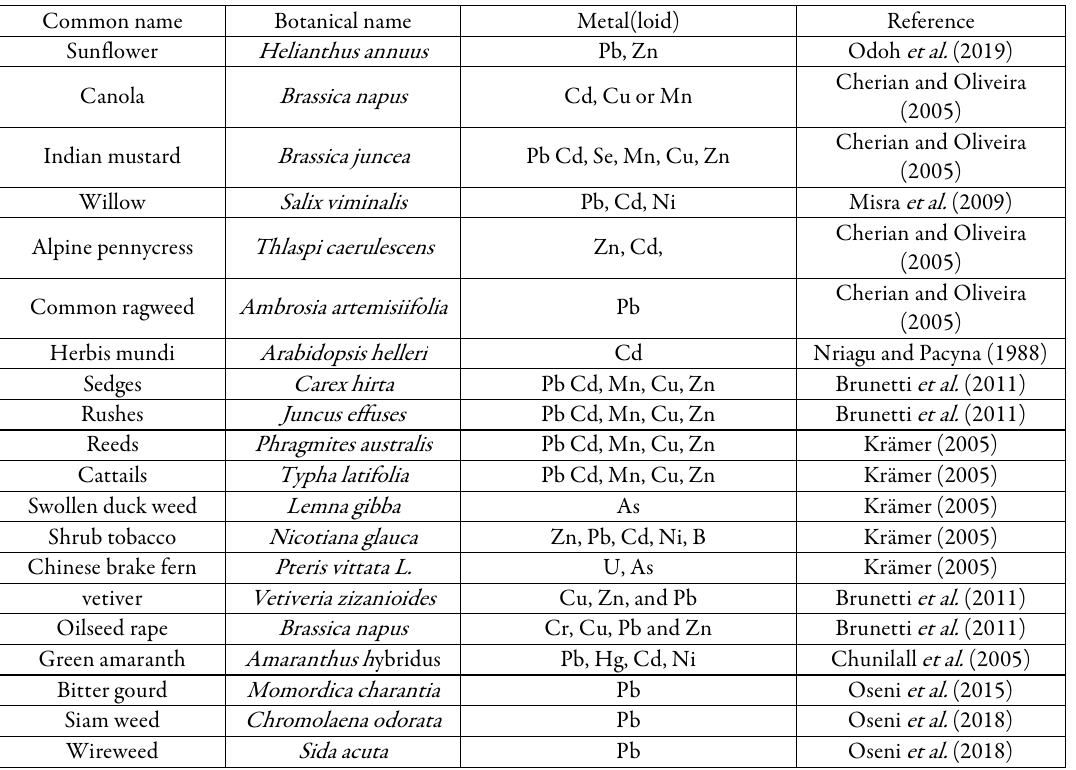
Table 1. Plants used for